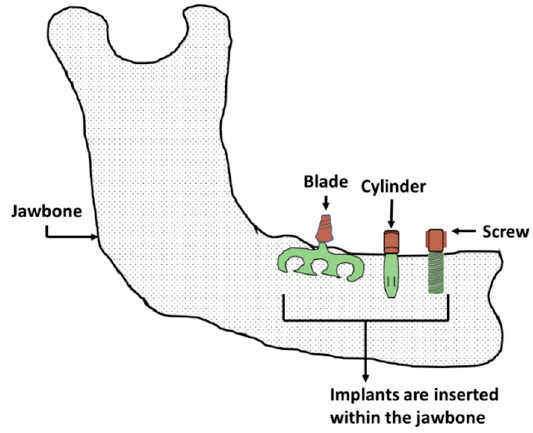
Figure 4. Endosteal or endosseous dental